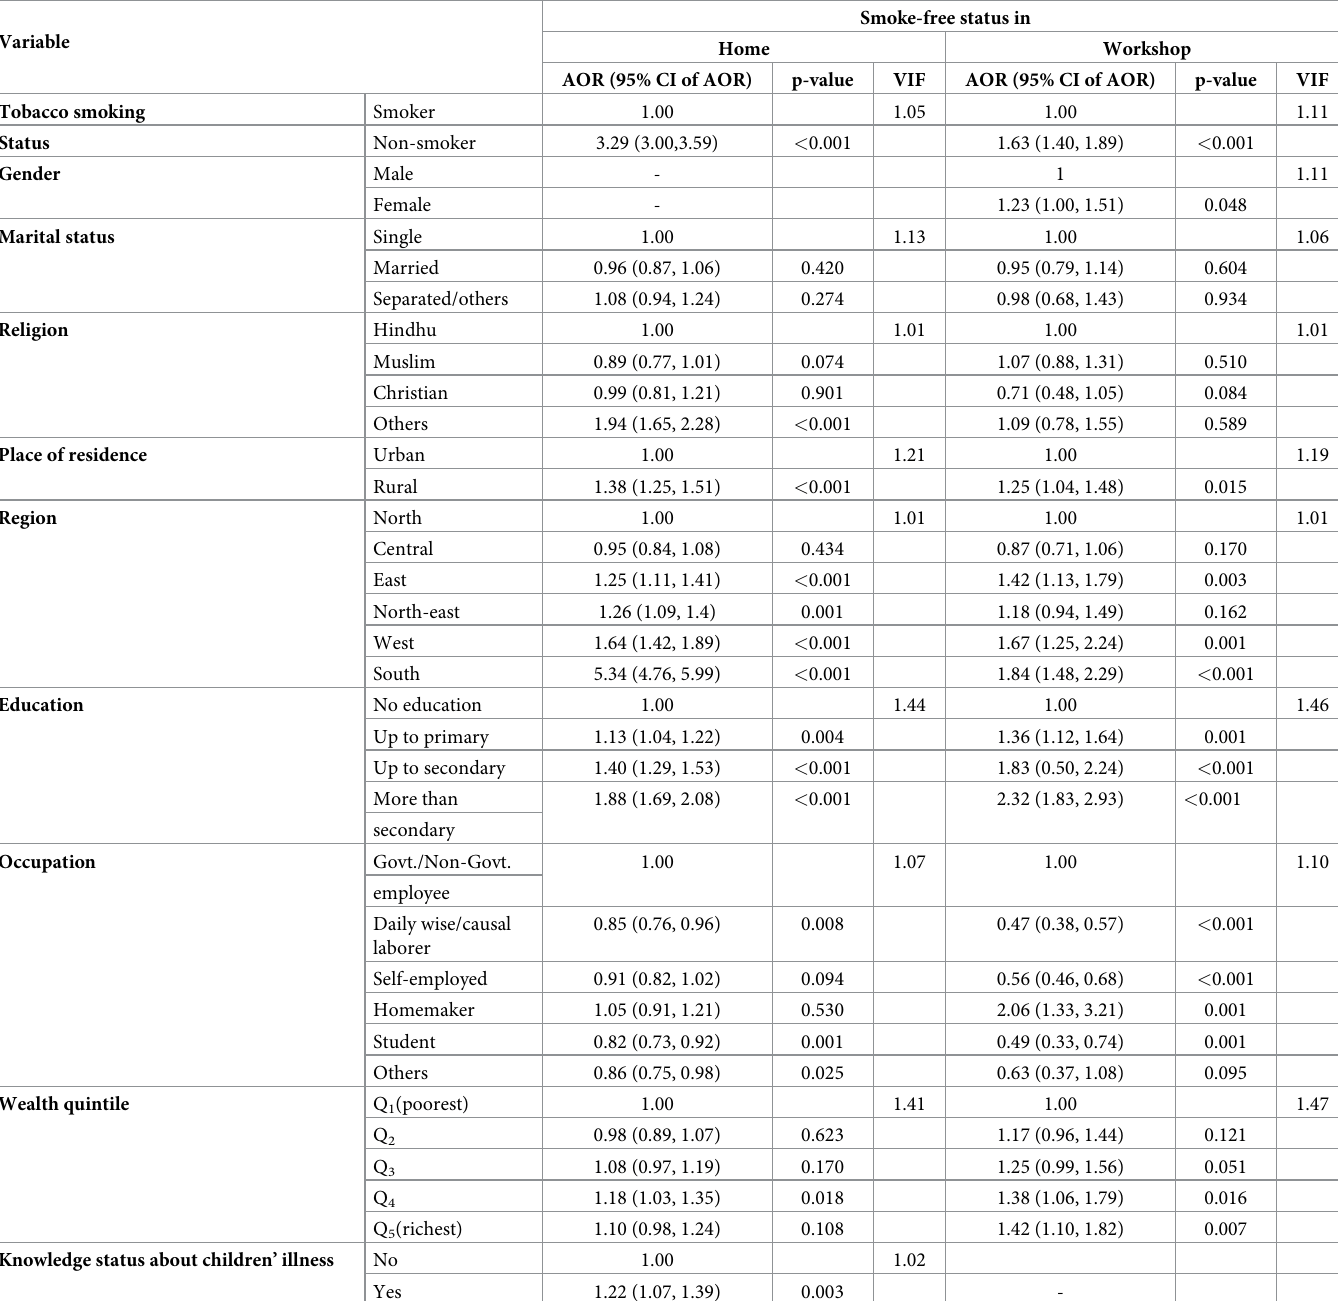
Table 3. Multivariable logistic regression